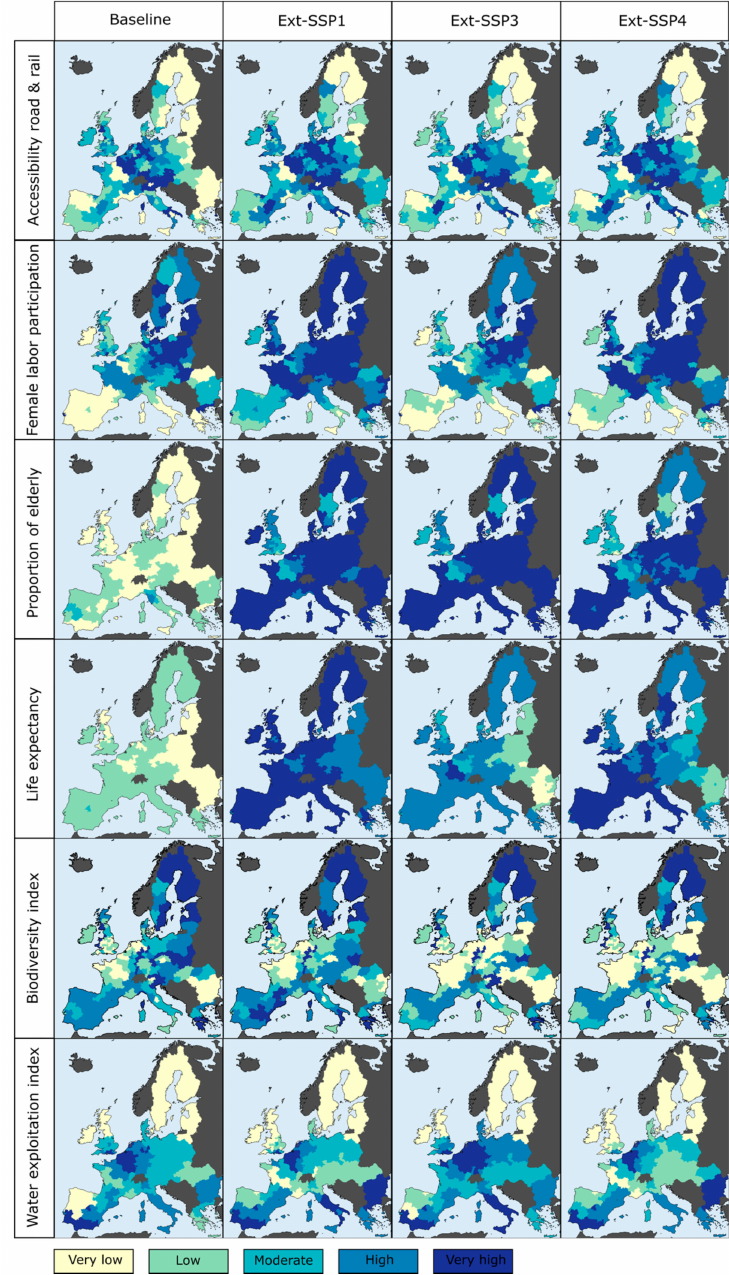
Figure 1. Sample of the available projections of variables related to human vulnerability, under the three extended SSPs (2050) and the baseline (2015) conditions, for the 28 member countries of the European Union, at the NUTS-2